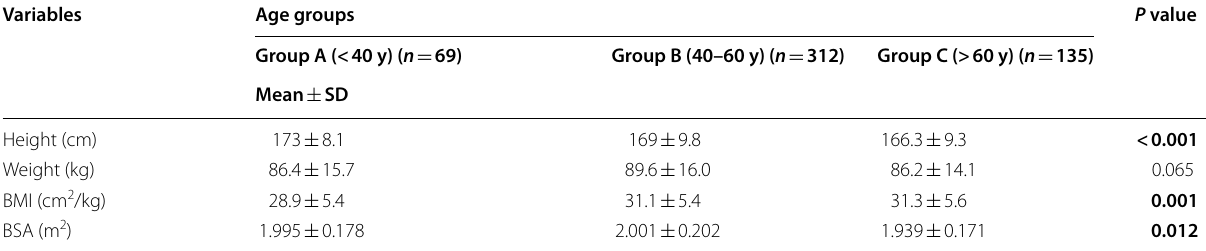
Bold mean significant values that is less than or equal 0.05 Table 10 Comparison of demographic and clinical characteristics among different age groups